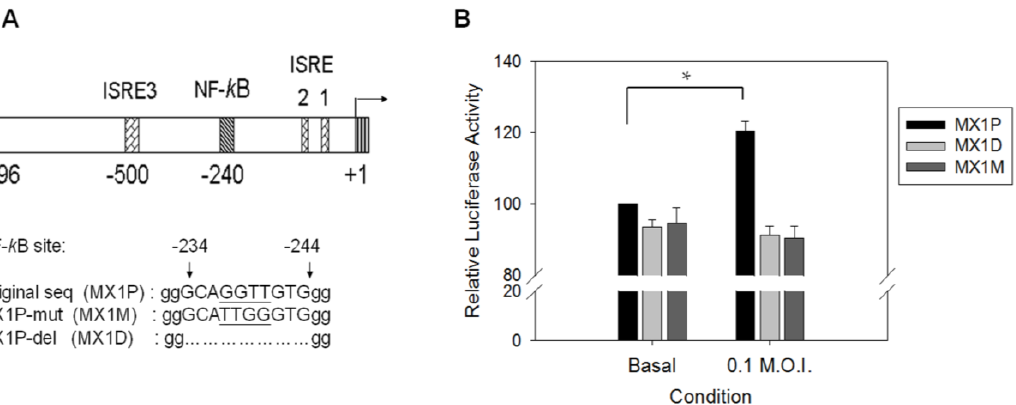
Figure 4. The promoter activity of MX1 gene can be modulated by NF-κB in HCoV 229E-infected cells. ( A ) Schematic presentation of the MX1 promoter region (−1 to −896). The transcriptional start site